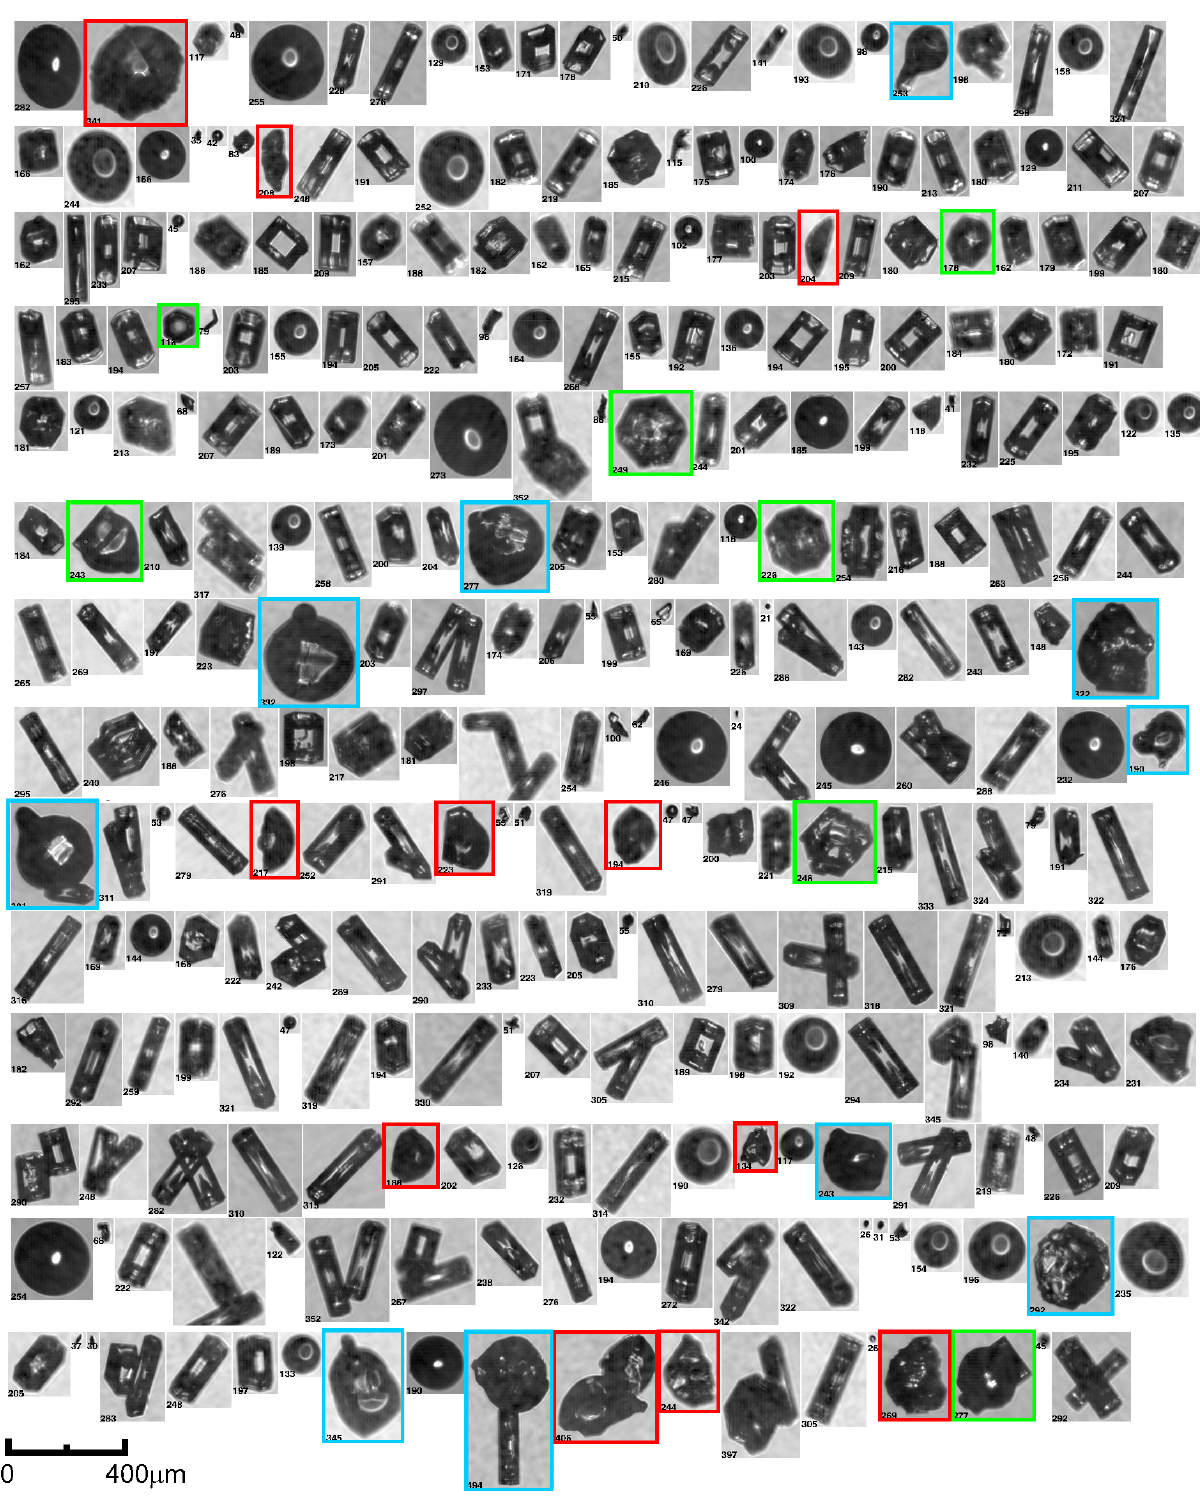
Figure 15. Spatial sequence of CPI images of droplets and faceted ice crystals. Blue frames indicate frozen droplets with modified shapes, green frames indicate frozen drops with developed facets, and red frames indicate fragments of shattered drops. Numbers under each image indicate their maximum size ( L max ). The images were sampled during 14:06:30–14:07:30UTC on 24 March 2017 (not shown in Fig. 13), at T a = − 3 ◦ C and H =